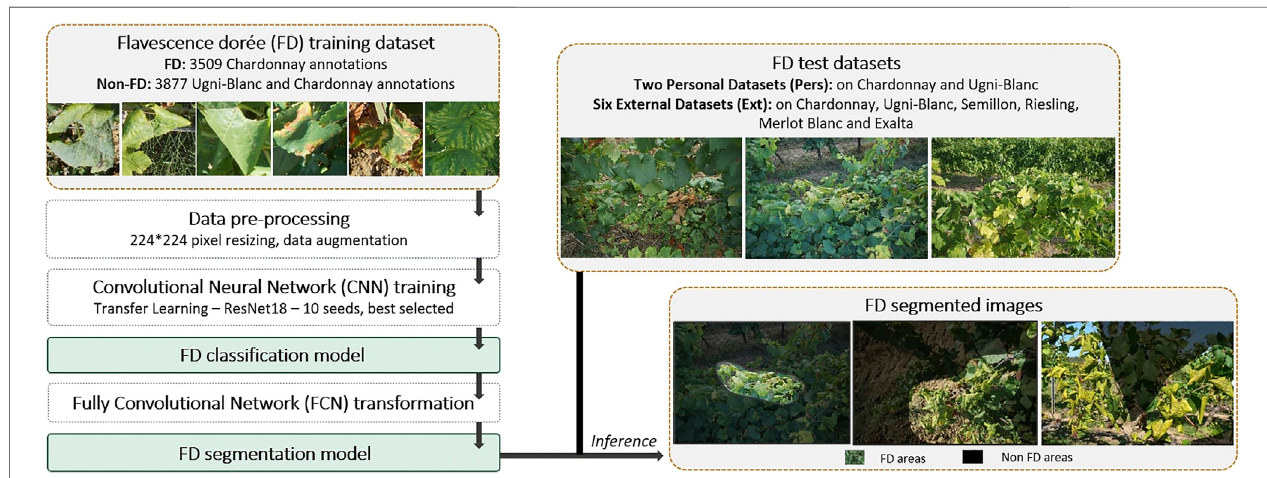
FIGURE 1 | Processing setup